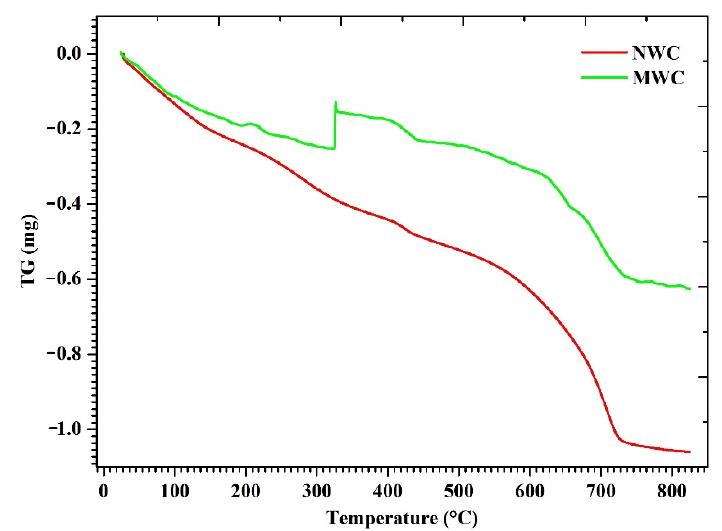
Figure 10. TGA curves for NWC and MWC.